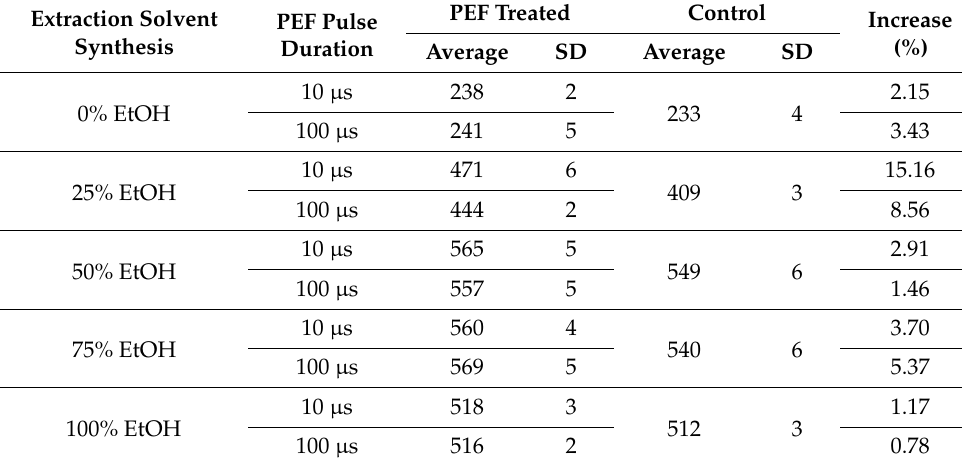
Table 1. DSC results on temperature ( ◦ C) of oxidation (T max ) of the various